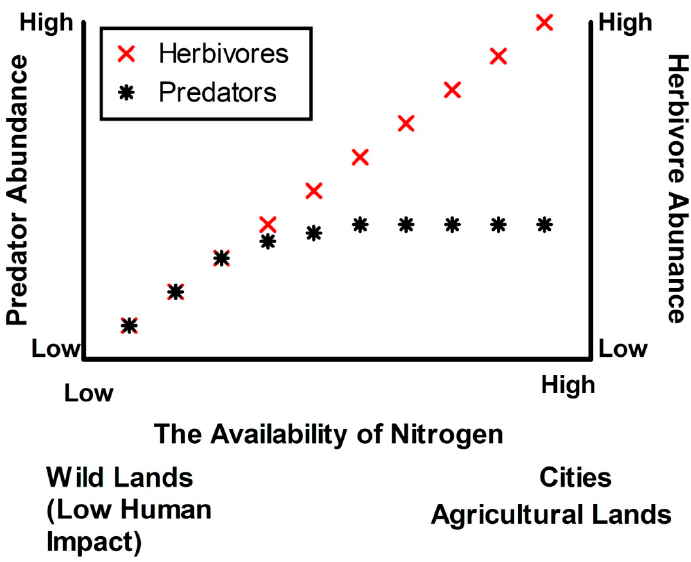
Figure 1. At low levels of N availability the positive effects of N fertilisation flow with efficiency through the trophic web. However, as N r pollution increases, there is a decoupling of herbivore and predator production. This decoupling is the result of: (1) nitrogen promoting weed growth, which gives herbivores a place to hide from predators; and (2) nitrogen improving the growth of individual herbivores placing them beyond the handling size of many predators.